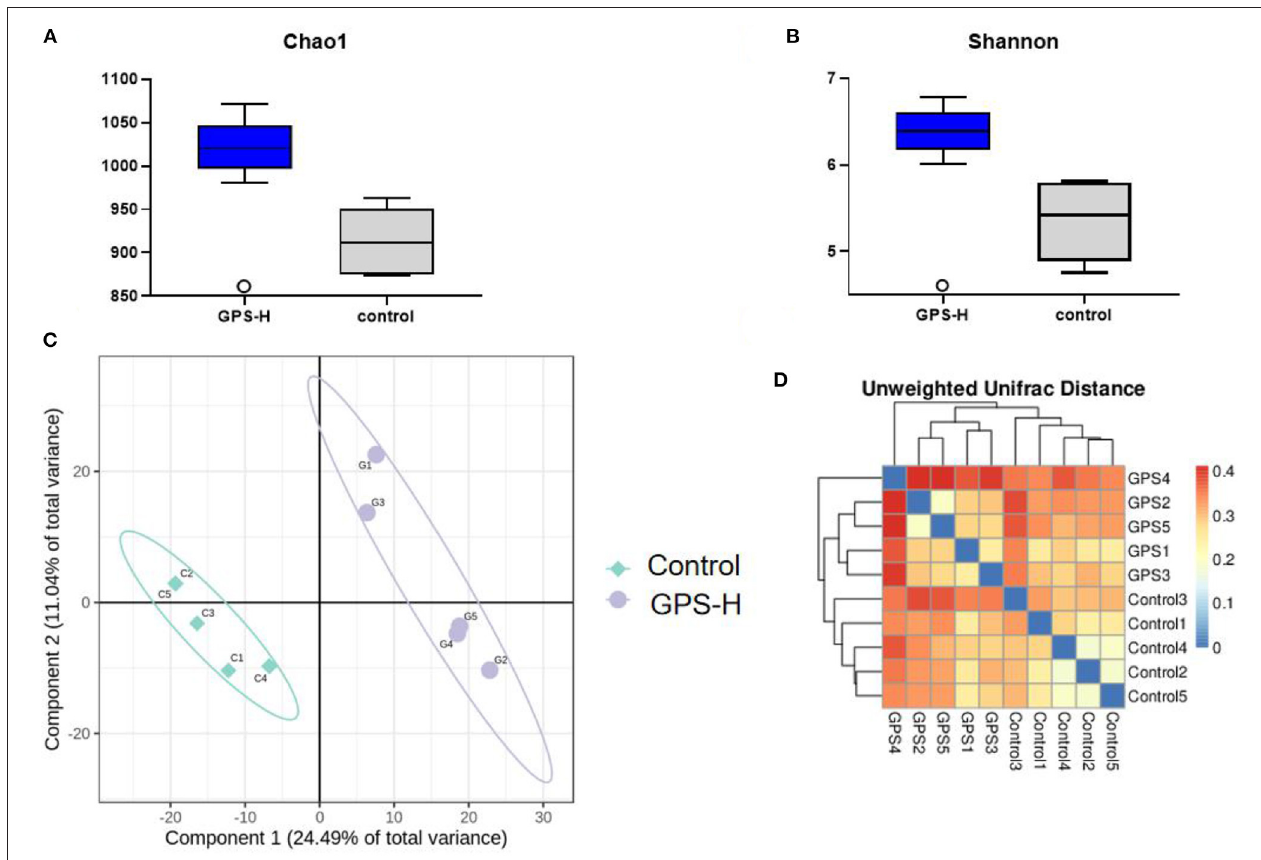
FIGURE 5 | Changes in gut microbes in GPS-H-treated and untreated layers. (A) Chao1 and (B) Shannon indices represent microbial richness and evenness, respectively, represents the change in the alpha diversity of gut microbes between the two groups of samples. And (C) principal component analysis (PCA) and (D) heat map relationship (the horizontal and vertical axes are the names of the samples, and the color depth represents the similarity between samples.) The analysis represents the beta diversity between each sample